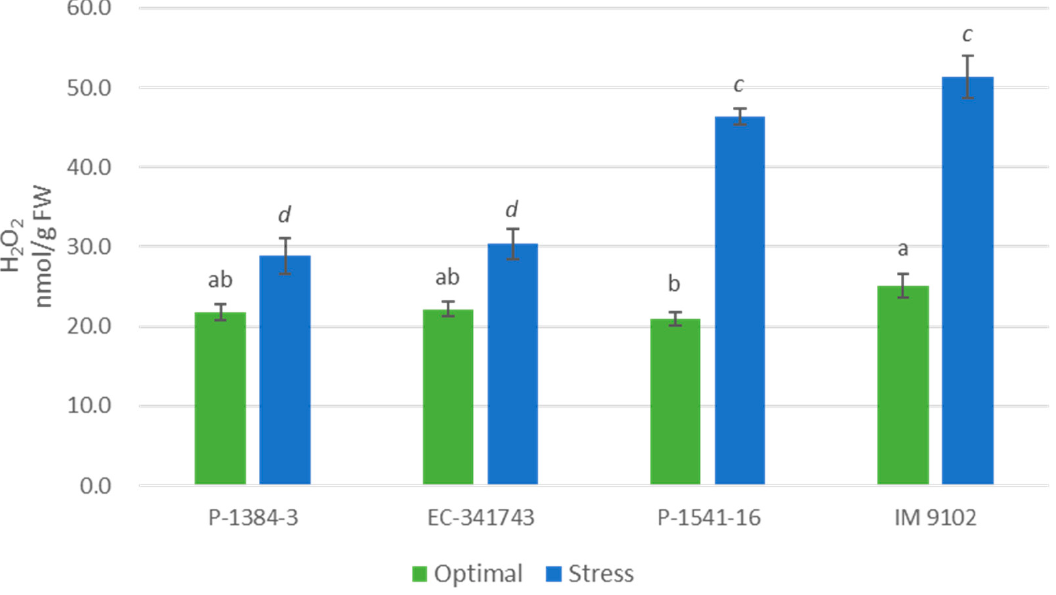
Figure 10. Hydrogen peroxide of four field pea genotypes under optimal and heat stress. Columns with different letters indicate significant difference at p ≤ 0.05 (Fisher LSD test).